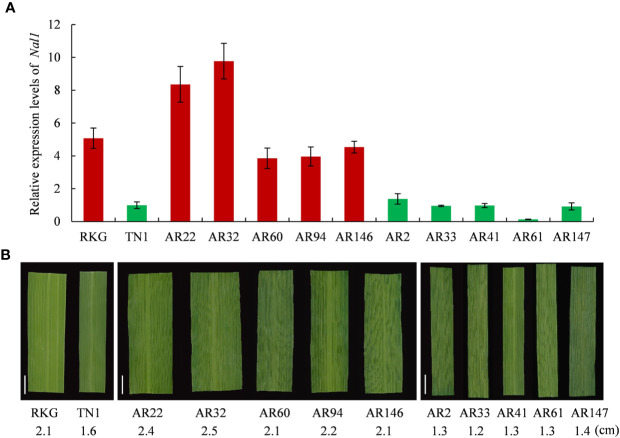
Expression analysis of NAL1 and comparison analysis of leaf width. (A) Relative expression levels of NAL1 in recombinant inbred line (RIL) parents, five wider leaf lines and five narrow leaf lines. (B) The corresponding leaf morphology and leaf width of (A). Scale bar = 1cm.